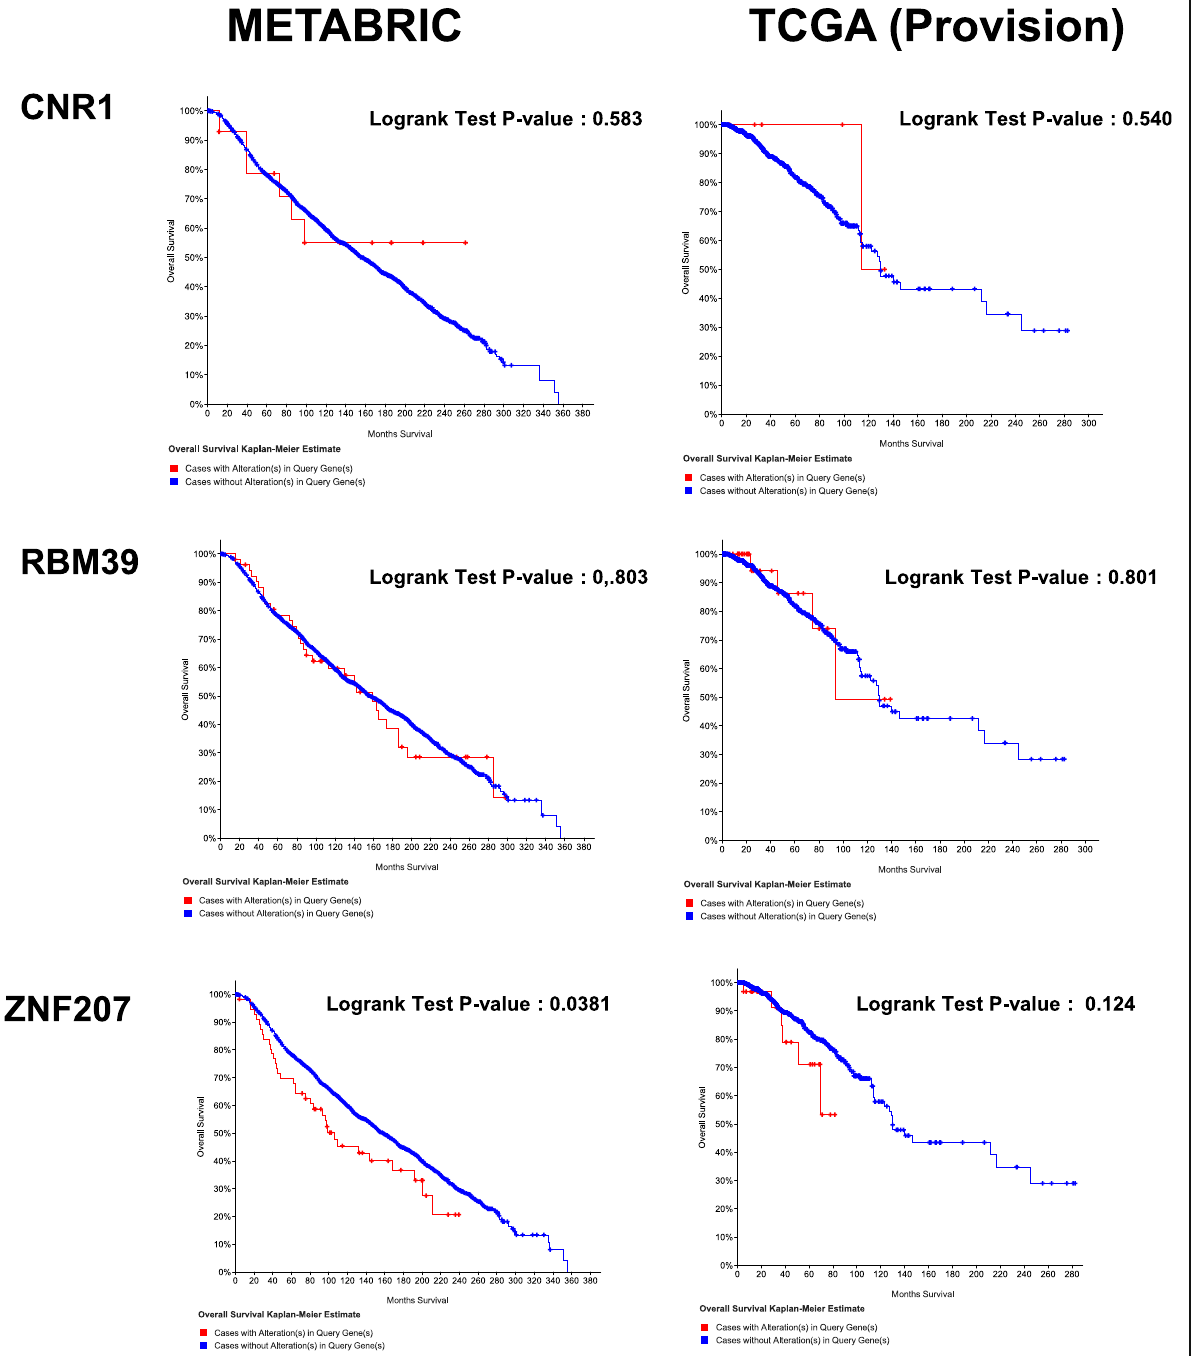
Fig. 5 Overall survival related to the genetic alterations in CNR1, RBM39, and ZNF207 across breast cancer patients using a study from METABRIC and TCGA (Provision), analyzed by